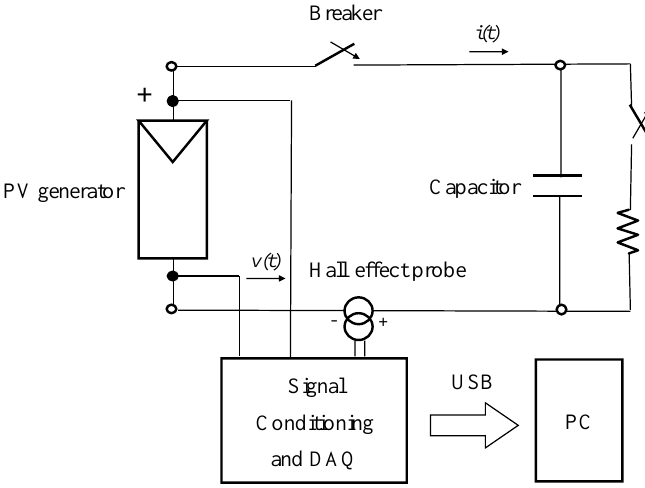
Figure 1. Measurement scheme for the I - V characterization of a photovoltaic (PV) generator by capacitive load.